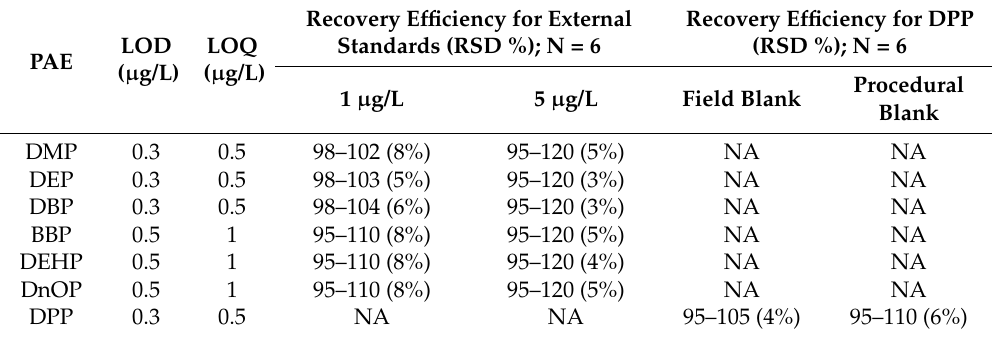
Table 2. Validation parameters of the optimized GC/MS methodology for PAE